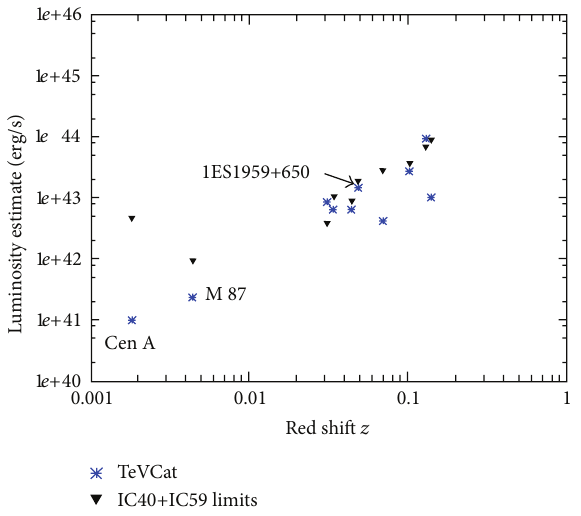
Figure 12: IceCube neutrino flux limits are compared with the TeV photon flux for nearby AGN. Figure courtesy of T. Gaisser